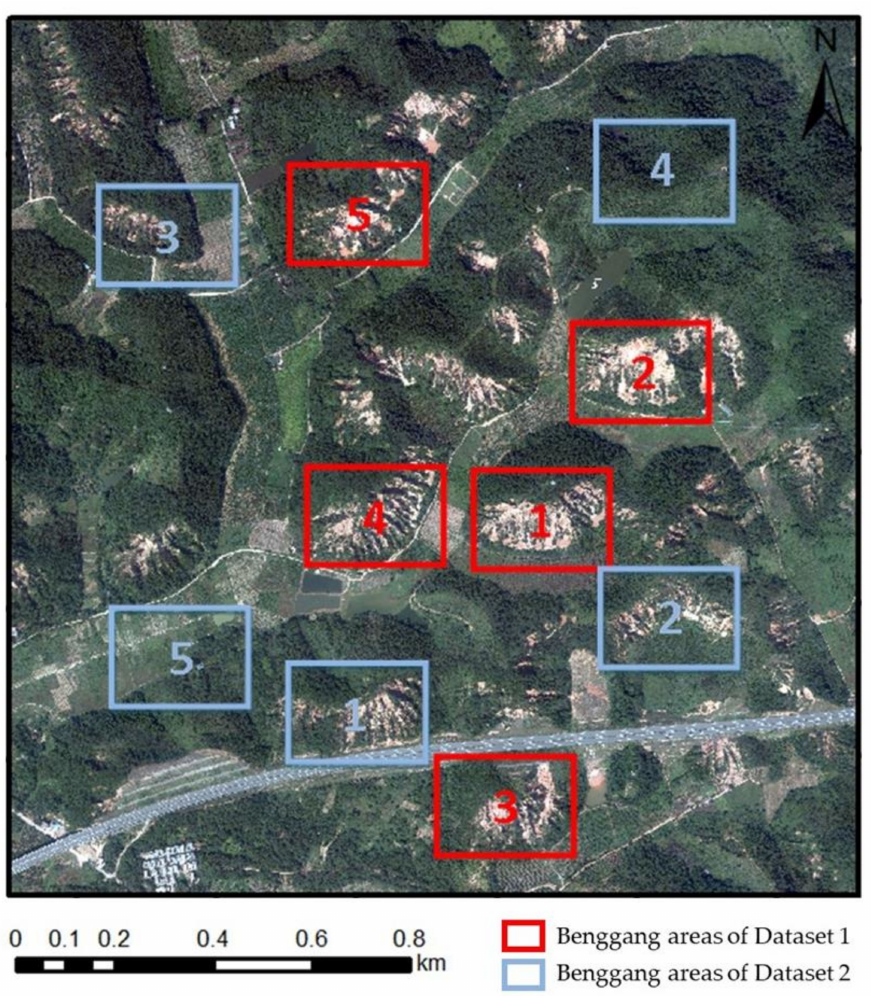
Figure 1. Study region. Benggang areas present heterogeneous structures and appearances (many have been covered with vegetation), making it challenging to detect the base in one single modality of data. The samples used in the first and the second experiments are marked with red and blue rectangles, respectively.